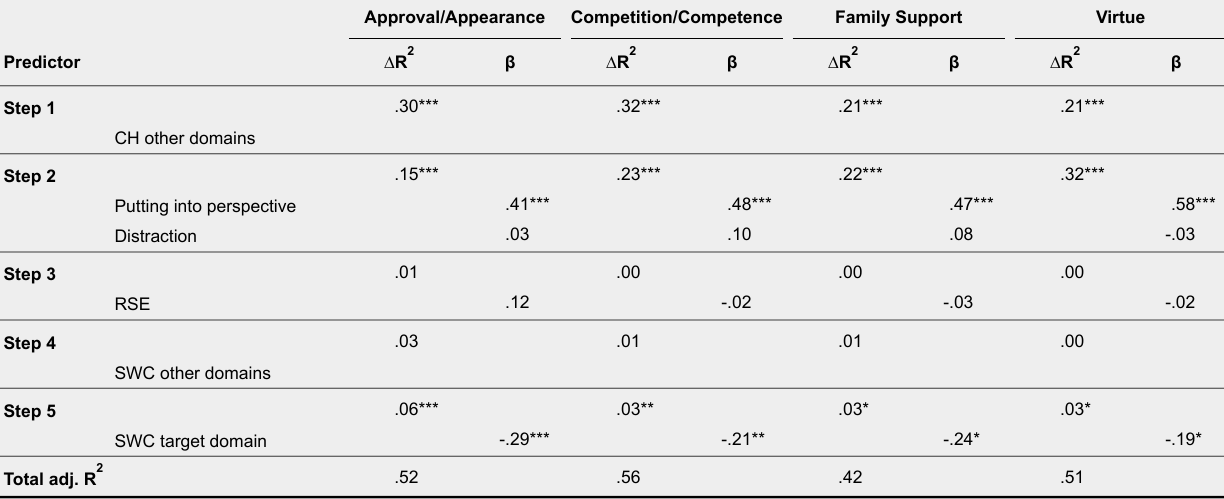
Hierarchical Multiple Regression Analyses Predicting Coping With Humor (CH) in a Self-Worth-Contingent (SWC) Domain